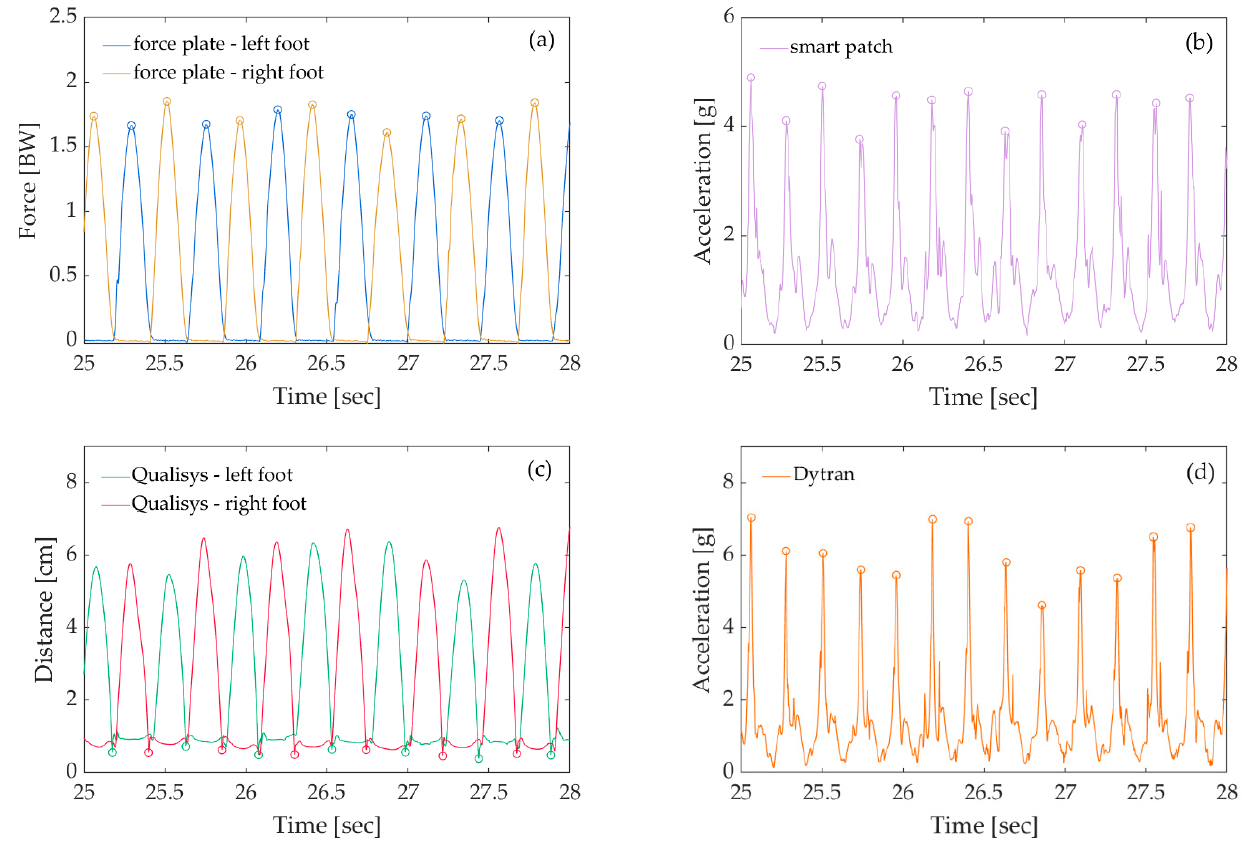
Figure 5. Examples of signals acquired from ( a ) the Qualisys motion capture system, ( b ) the S2P bilateral force plates, ( c ) the Dytran accelerometers, and ( d ) the smart patch. The circles on the graphs represent the peaks and valleys from which the step rate was calculated.